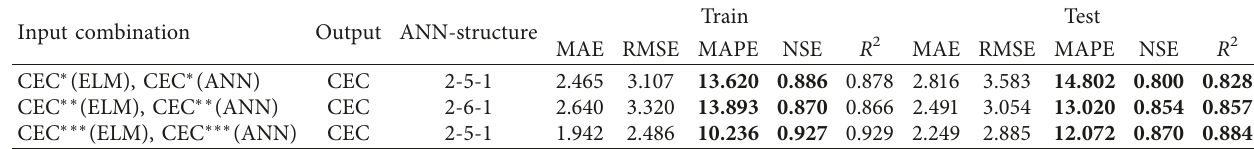
Table 6: The performance of MM-GANN models for the three best input combinations.